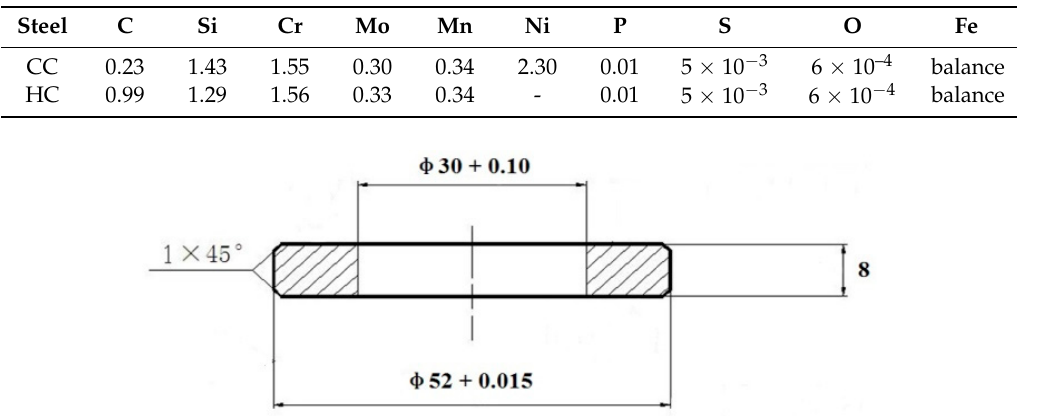
Figure 1. Sketch of RCF test specimen, (mm).